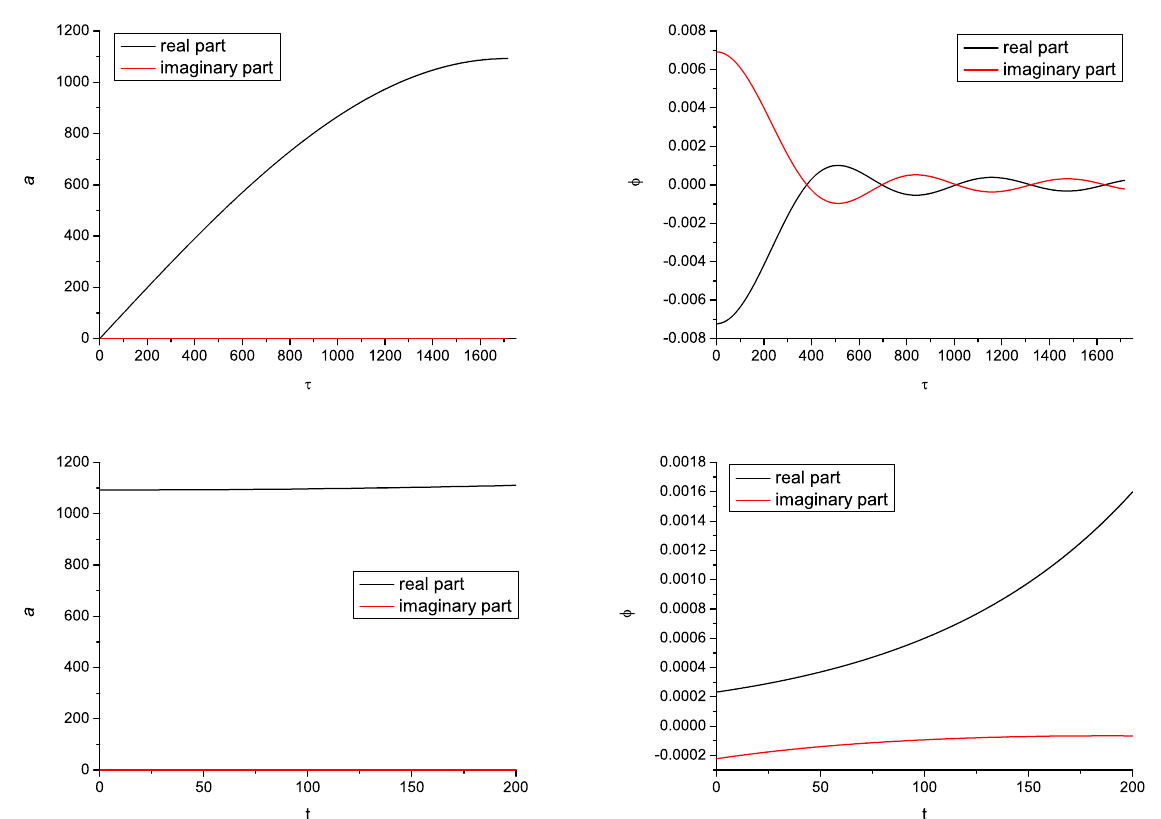
Figure 4. A fuzzy instanton solution ( φ 0 = 0.01) of a toy potential V = V 0 − ( 1/2 ) m 2 φ 2 + ( 1/24 ) λφ 4 , where V 0 = 10 − 7 , m 2 = 10 − 4 , and λ = 2 × 10 − 2 . The top figures depict Euclidean time, while the bottom figures depict Lorentzian time. During Euclidean time, the field rapidly oscillates along the hilltop ( φ = 0 in this potential, top right ). After the Wick-rotation, the field rolls in the left or right direction ( bottom right ).